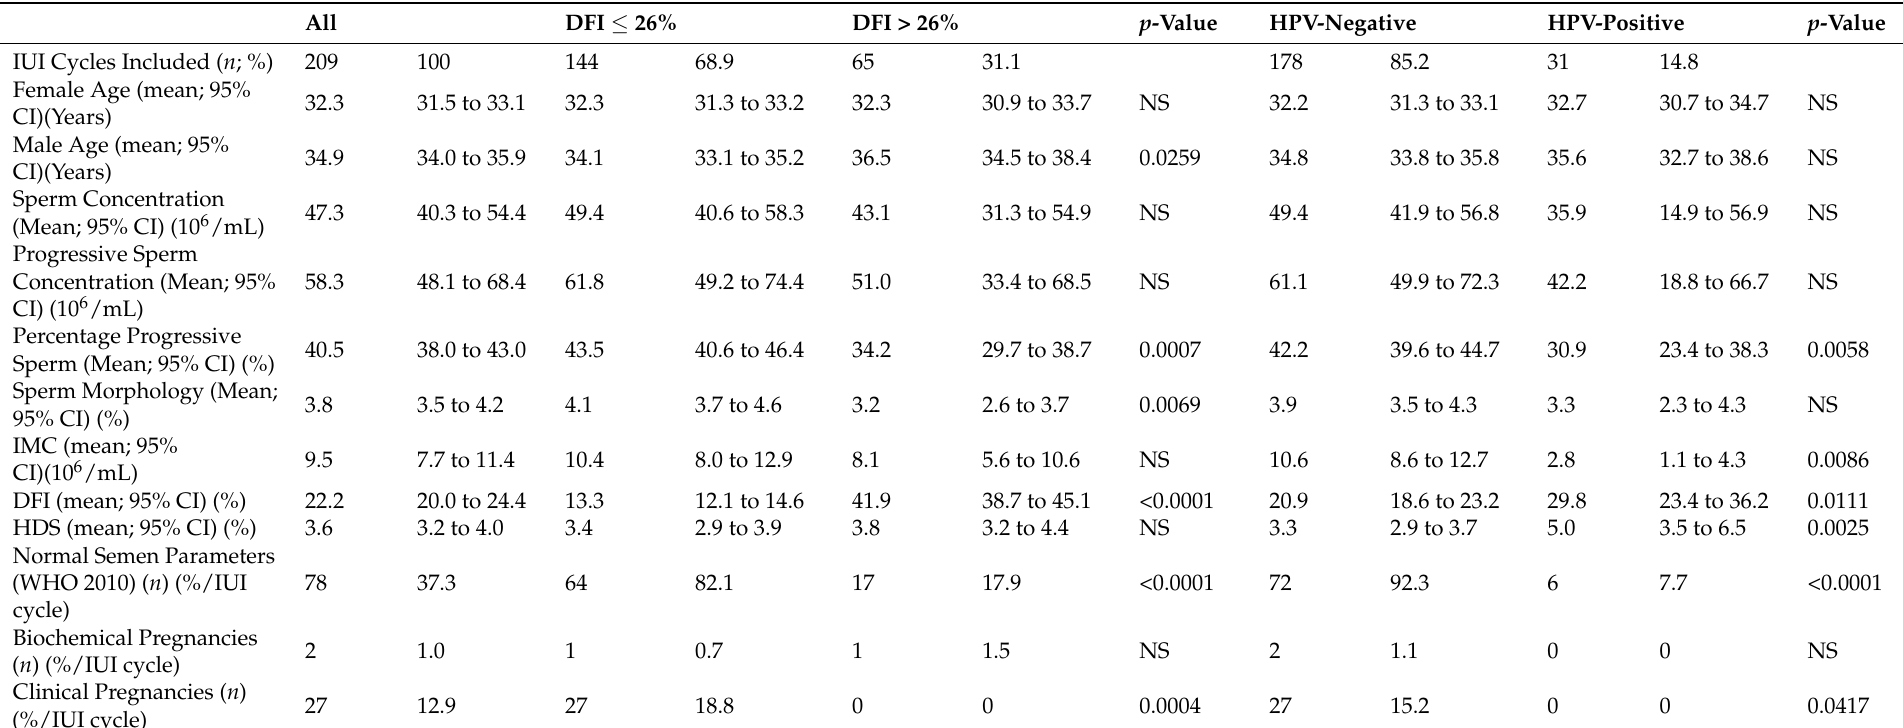
Table 1. Couple characteristics and demographic data on 209 intra-uterine insemination (IUI) cycles divided according to low DNA fragmentation index (DFI) ( ≤ 26%) and high DFI (>26%) and Human Papillomavirus (HPV)